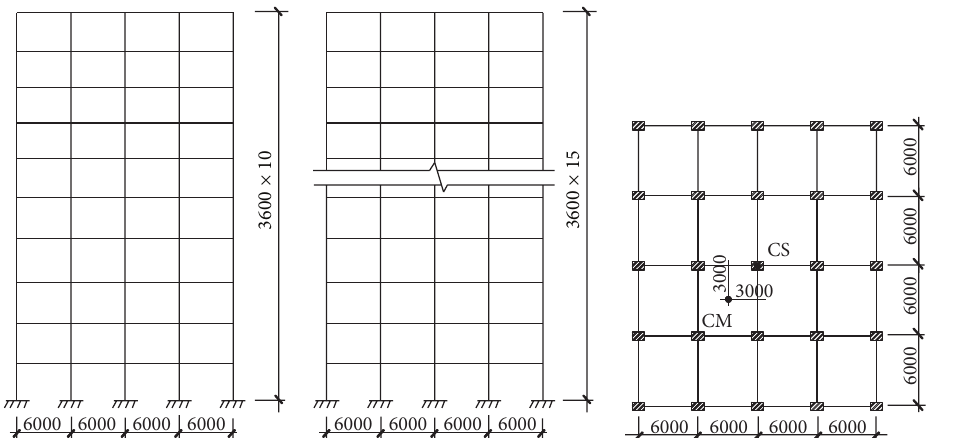
Figure 4: Schematic of example buildings.